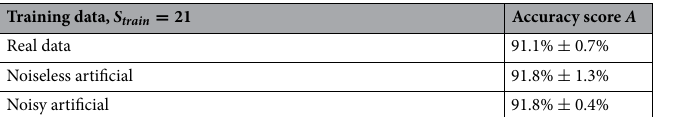
Training data, S train = 21